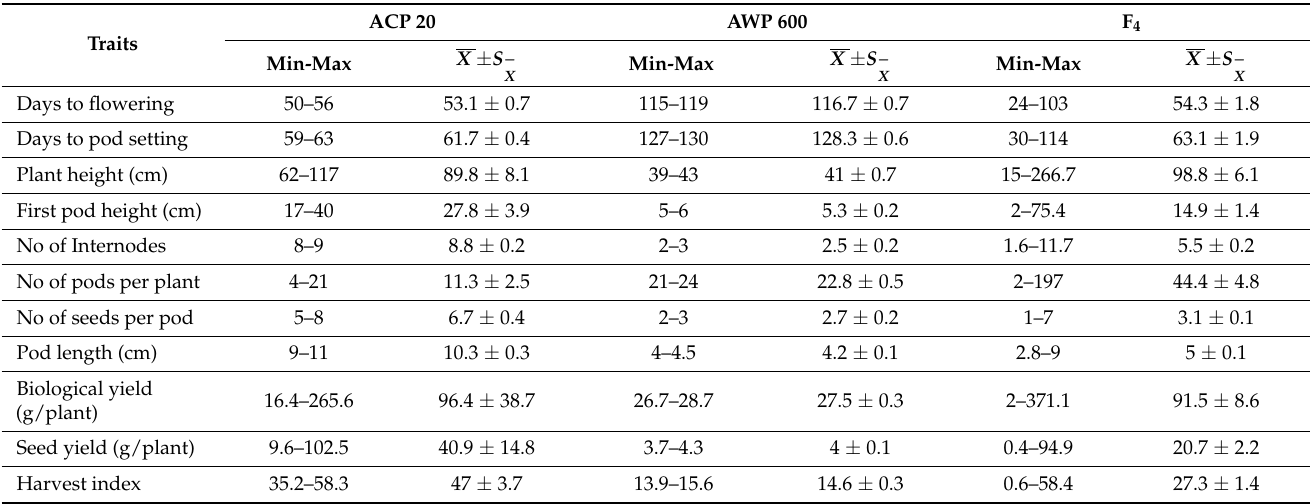
Table 2. Minimum (Min) and maximum (Max) values, means ( X ) and ± standard errors ( S phenological and morphological traits in parents and F 4 population originated from interspecific crosses P. sativum × P. fulvum